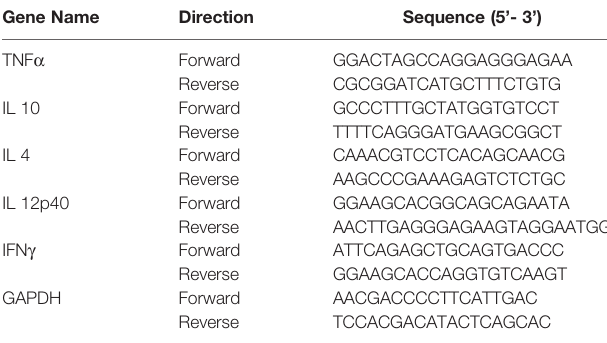
TABLE 2 | List of cytokine primers used for qPCR